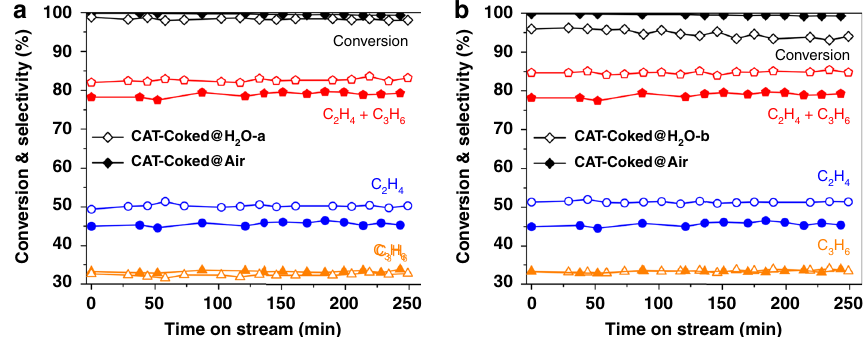
Fig. 6 Implementing the coke transformation strategy over CAT catalysts in a pilot plant. a MTO reaction performances over the CAT-Coked sample completely regenerated by air combustion at 953 K (abbreviated as CAT-Coked@Air) and treated by steam at 953 K with the water feed of 500 g h − 1 (abbreviated as CAT-Coked@H 2 O-a). b MTO reaction performances over the CAT-Coked@Air sample and CAT-Coked sample treated by steam at 953 K with the water feed of 300 g h − 1 (abbreviated as CAT-Coked@H 2